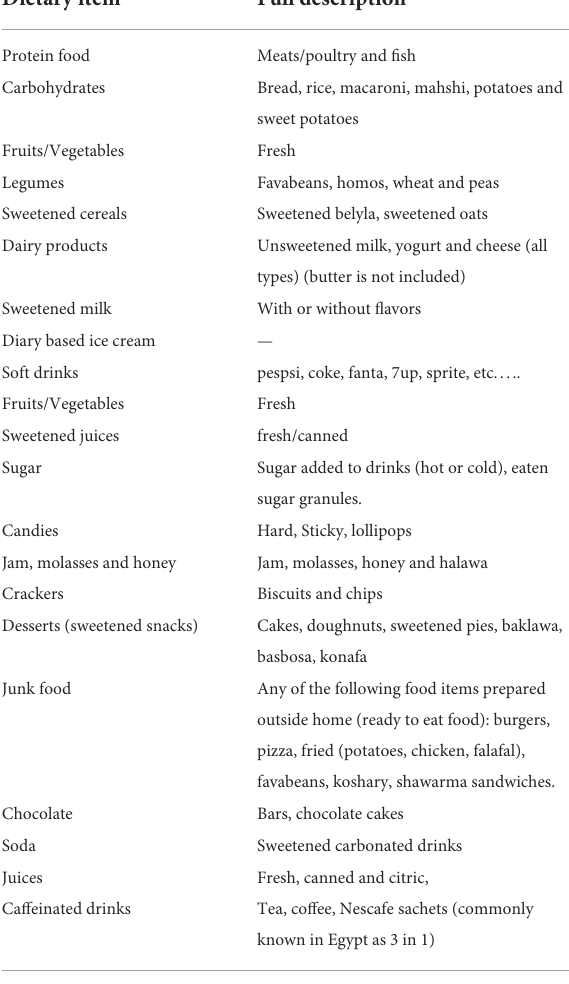
TABLE 1 Description of investigated dietary